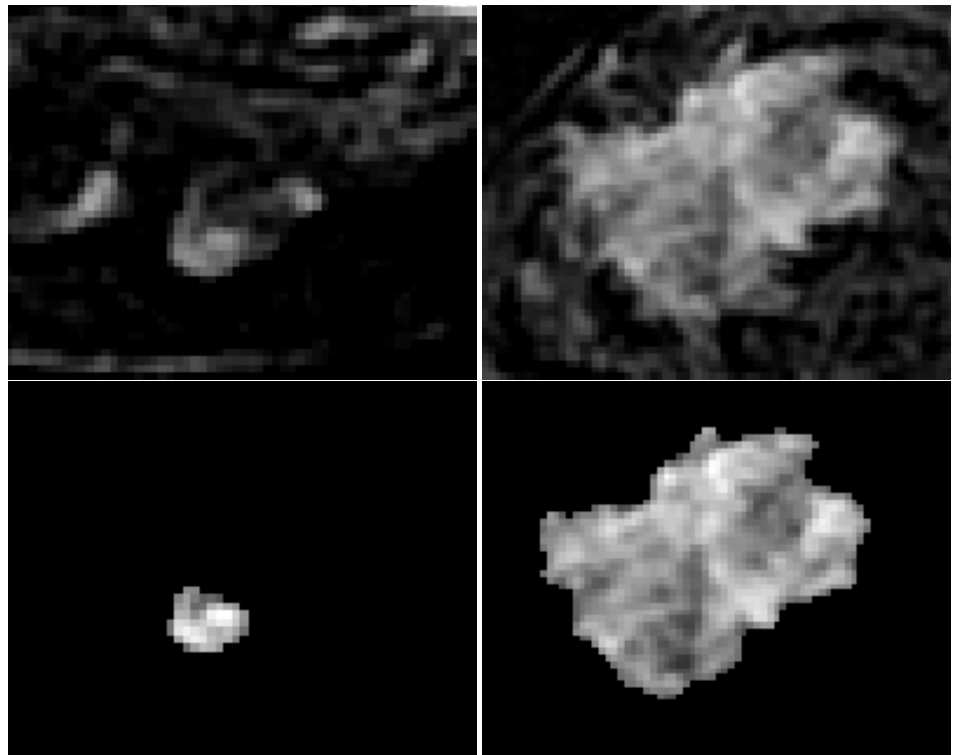
Figure 7. Two examples of segmentation obtained by sFCM: ( 1st row ) the original DCE-MRI images; ( 2nd row ) the corresponding segmentation. Compared to the images shown in Figures 4 and 6, a 2 × zoom factor was used, that allows us to better appreciate the lesion non-homogeneity that only clustering approaches can properly manage, thus maximizing the final result